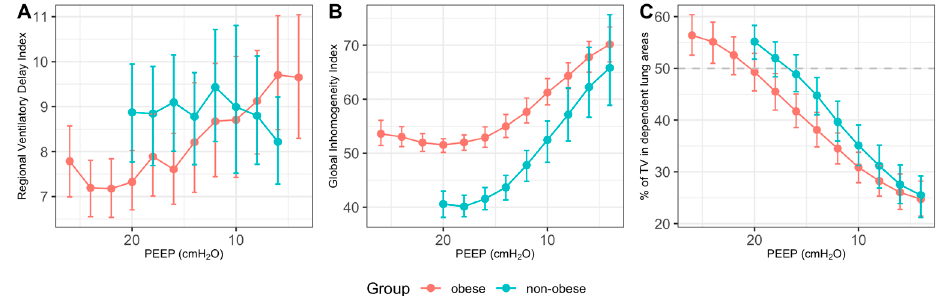
Figure 5. Course of mean Regional Ventilatory Delay Index ( A ), mean Global Inhomogeneity Index and mean distribution of tidal ventilation to dependent (dorsal) lung areas in obese (red) and non-obese patients (green) during the decremental PEEP trial. While RVD shows considerable interindividual variation at each PEEP step ( A ), GI ( B ) is minimal at a PEEP of 18 cm H 2 O in normal weighted patients and at 20 cm H 2 O in obese patients. Likewise, best PEEP values according to the TV distribution method show best PEEP values at 20 cm H 2 O for obese patients and 16 cm H 2 O for non-obese patients ( C ).